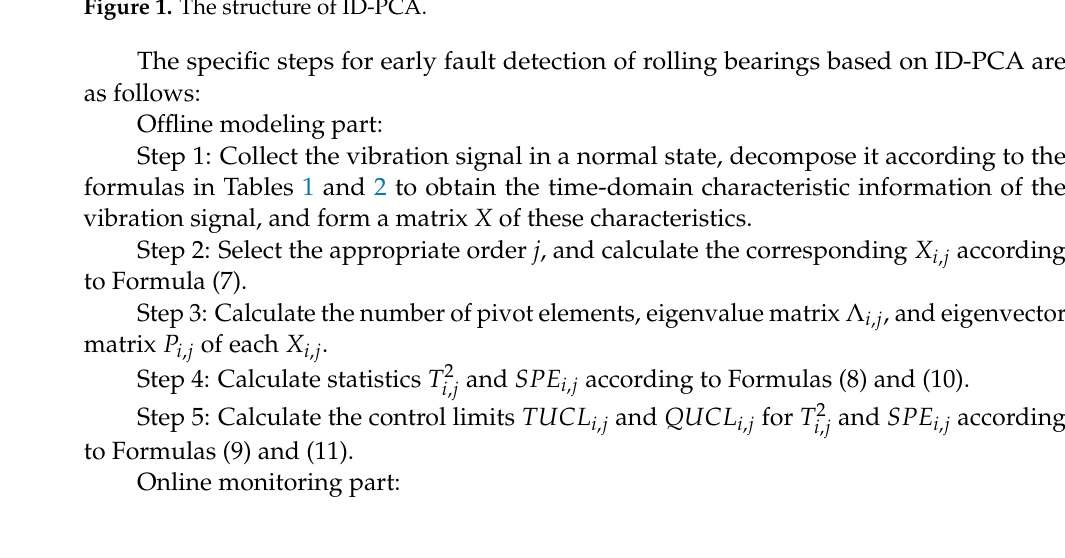
Figure 1. The structure of ID-PCA.